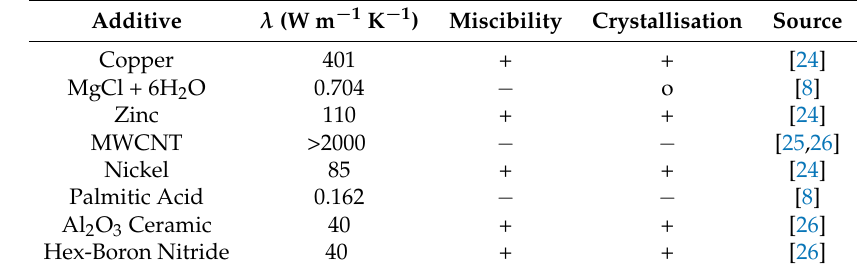
Table 3. Influence of screened additive powders on Xylitol as an example PCM to increase the thermal conductivity and the crystallization rate. Legend: +: better/improved; − : worse/deteriorated; o: no